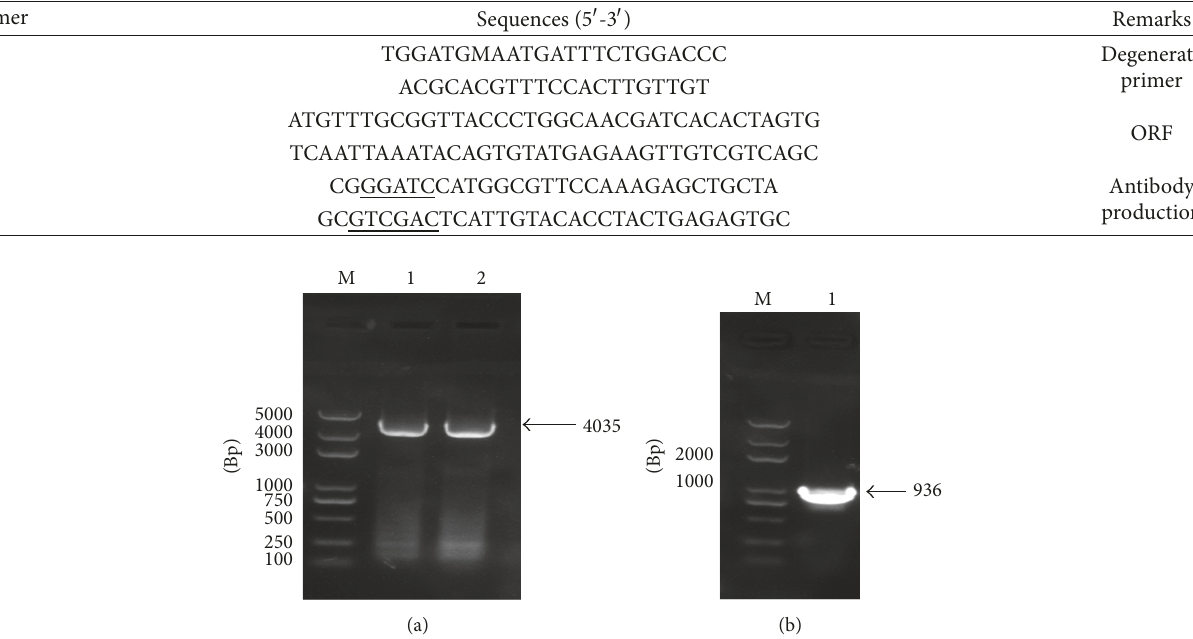
Figure 3: PCR amplification of rhoptry neck 2 gene of Babesia orientalis from gDNA and cDNA and amplification of fragment used for polyclonal antibody production . (a) M: nucleotide marker (15000 bps), line 1: amplification of Bo RON2 genomic DNA open reading frame showing a specific band of 4035 bp, and line 2: amplification of cDNA showing to have the same size with genomic DNA. (b) Line 1, the amplicon of product used for polyclonal antibody.